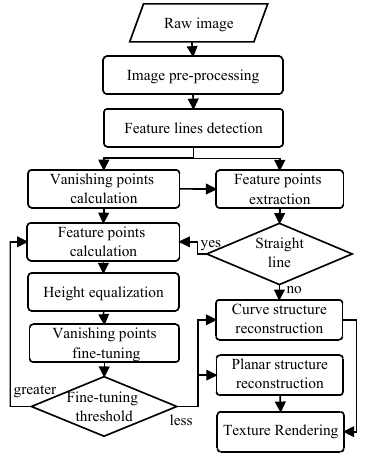
Figure 1. Building model reconstruction procedure